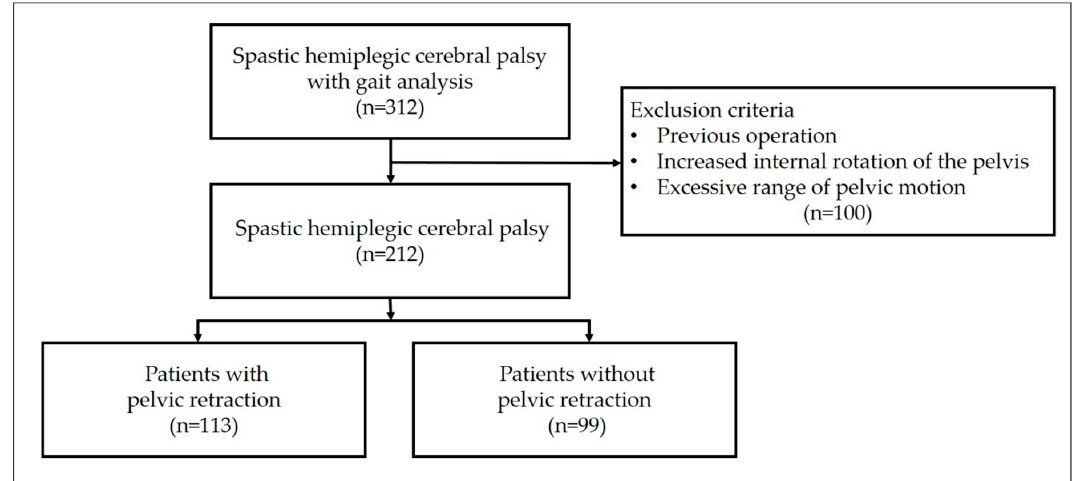
Figure 2. Flow diagram of inclusion and exclusion criteria in the study.